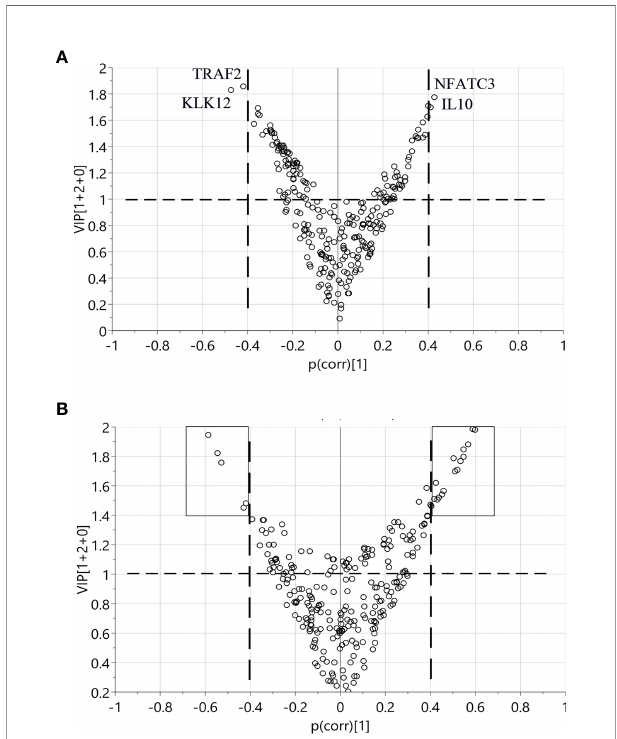
FIGURE 3 | Identi fi cation of discriminant factors between two groups of samples according to OPLS-DA. Variables with | p(corr) | > 0.4 and VIP > 1 were selected. (A) Comparison between < 5 years pre-diagnostic samples and the matched controls. Four proteins selected as potential discriminant factors were shown. (B) Comparison between plasma at diagnosis and the matched controls. The black boxes indicate the 21 proteins as discriminating